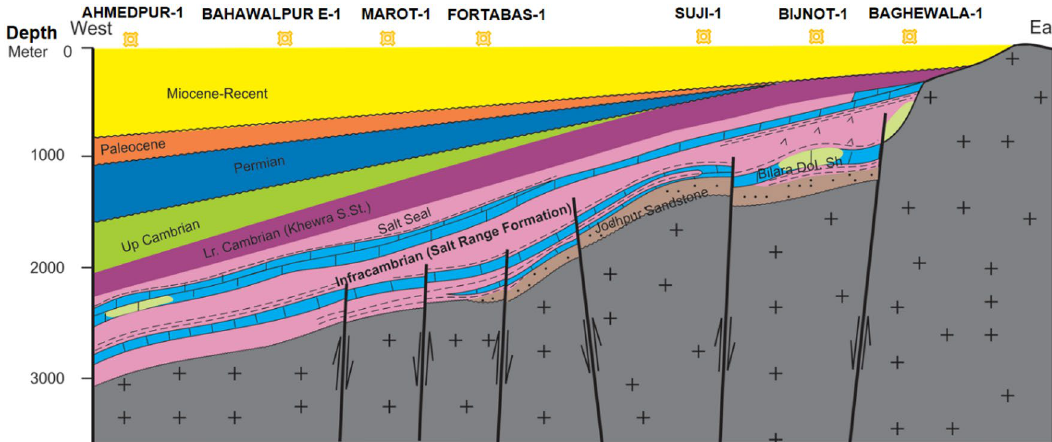
Figure 3. Regional schematic stratigraphic cross-section and structural interpretation along with the SE Pakistan and part of Bikaner–Nagaur Basin India. CorelDRAW X5 was used to create the illustration (www. corel draw. com).